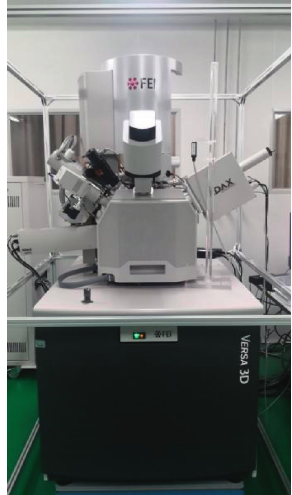
Figure 16: The Hitachi S-3400N scanning electron